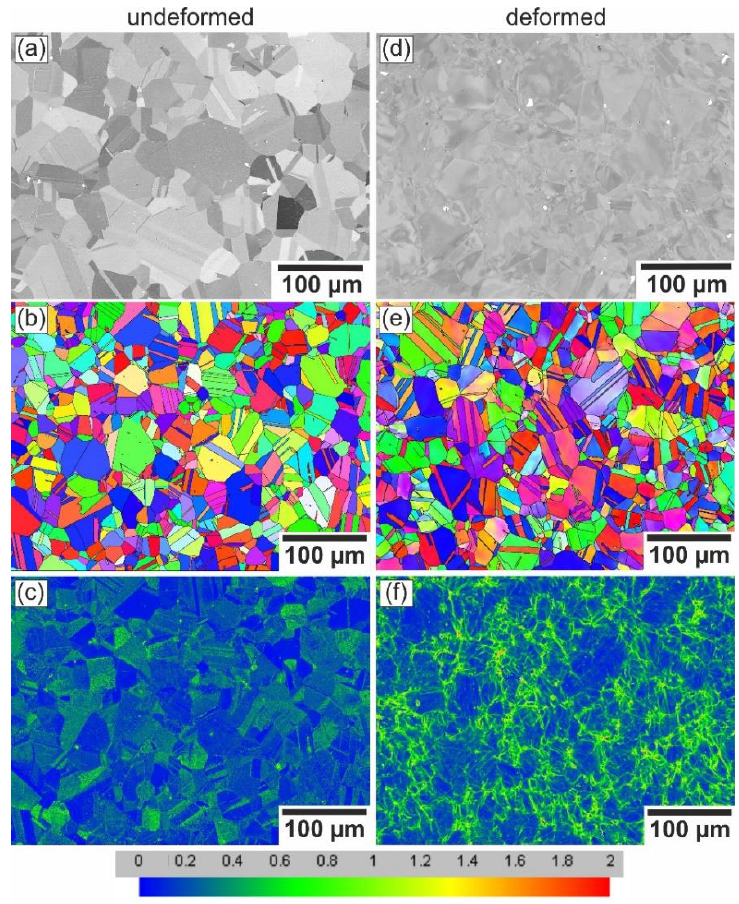
Figure 7. Comparison of the ( a ) BSE and ( b ) EBSD images of the undeformed specimen with the ( d ) BSE and ( e ) EBSD images of the deformed microstructure of the specimen measured at room temperature. ( c , f ) show the local misorientation of the undeformed and deformed specimen with a threshold of 3 degrees.